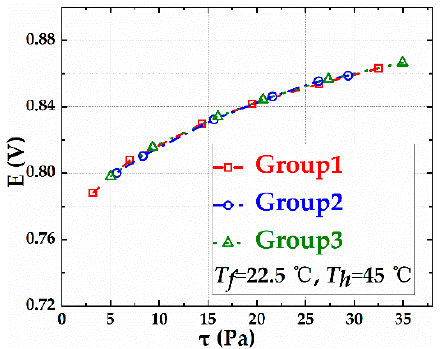
Figure 6. The repeated data of the experimental system with the sensor S1.